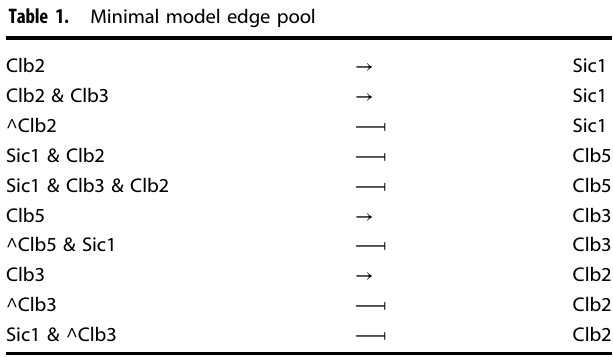
Table 1. Minimal model edge pool